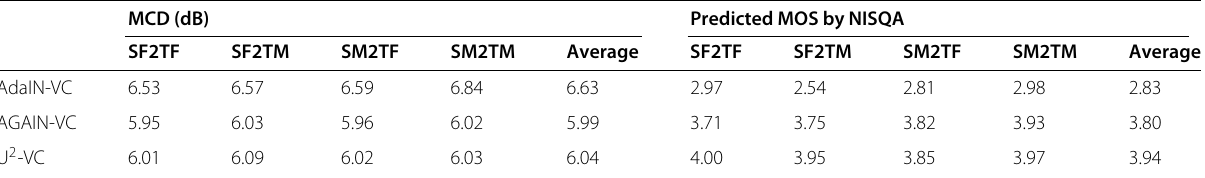
Table 8 Objective comparison results of mono-lingual conversion in unseen-to-unseen